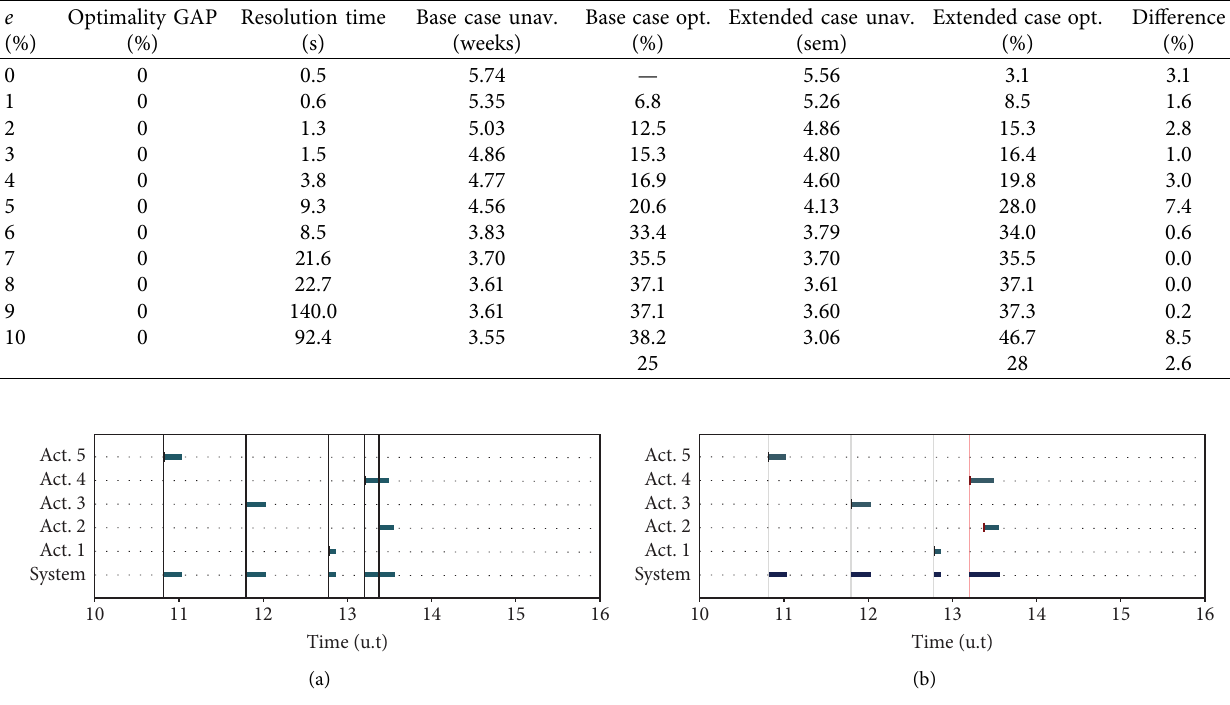
Figure 6: Comparative scheme between both models with e � 0%. (a) Base case. (b) Current